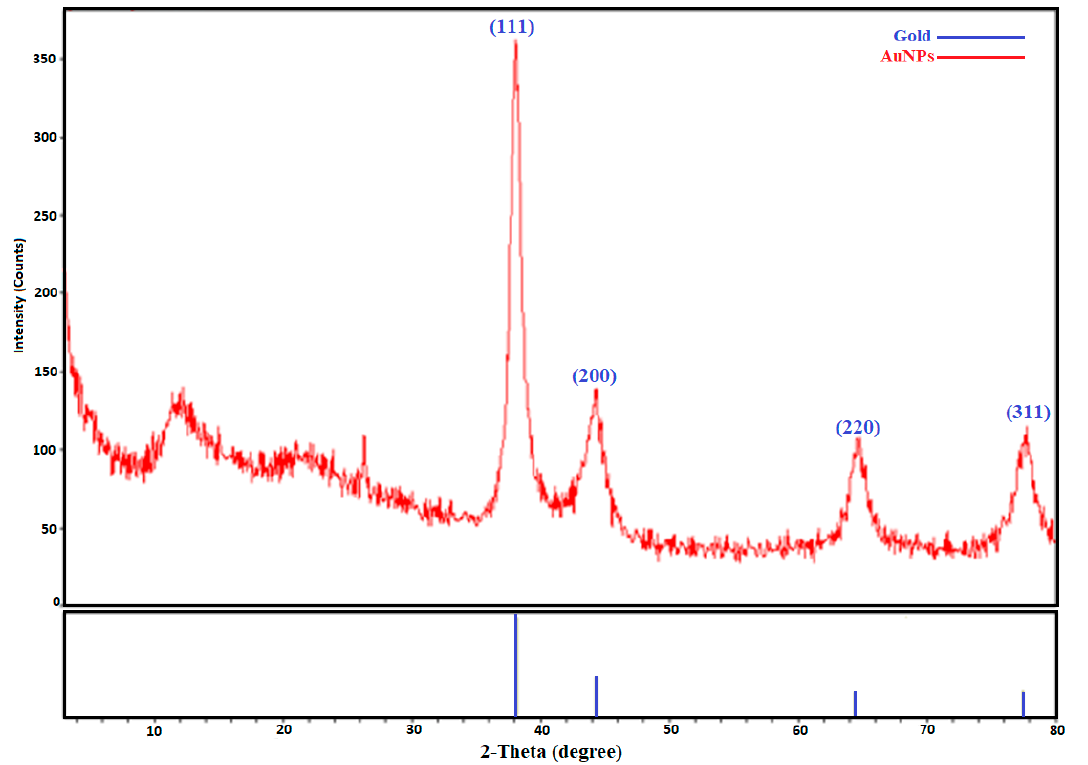
Figure 3. X-ray diffractogram of biogenic gold nanoparticles.